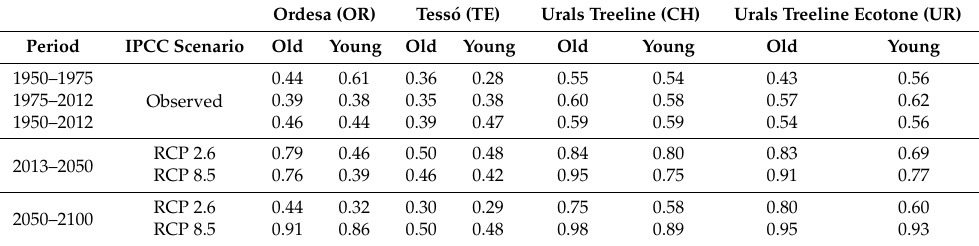
Figure 5. Simulated (1950–2012 period) and projected mean monthly growth response curves considering temperature ( gT , symbols) and soil moisture ( gM , lines) for each age group (blue, old trees; red, young trees) at the studied treeline sites. Projected growth response curves correspond to two IPCC AR5 emission scenarios (RCP 2.6 and RCP 8.5, with +0.3° and +4.8° C projected warming, respectively) and to the 2050–2100 period. The arrows show the estimated period with temperature above the minimum thresholds for growth ( T 1 ). Sites’ codes are as in Table 1. Table 3. Pearson correlation coefficients calculated between observed site series of tree-ring width indices (TRWi) and VS-Lite indices (TRWi VSL ) for the calibration period (1950–2012); and for the sub-periods 1950–1975 and 1975–2012, also considering projected site series of tree-ring width indices (TRWip) and VS-Lite future indices (TRWip- VSL ) for the periods 2013–2050 and 2050–2100 and two IPCC AR5 emission scenarios (RCP 2.6 and RC P 8.5). Correlation values higher than 0.25 are significant at p <